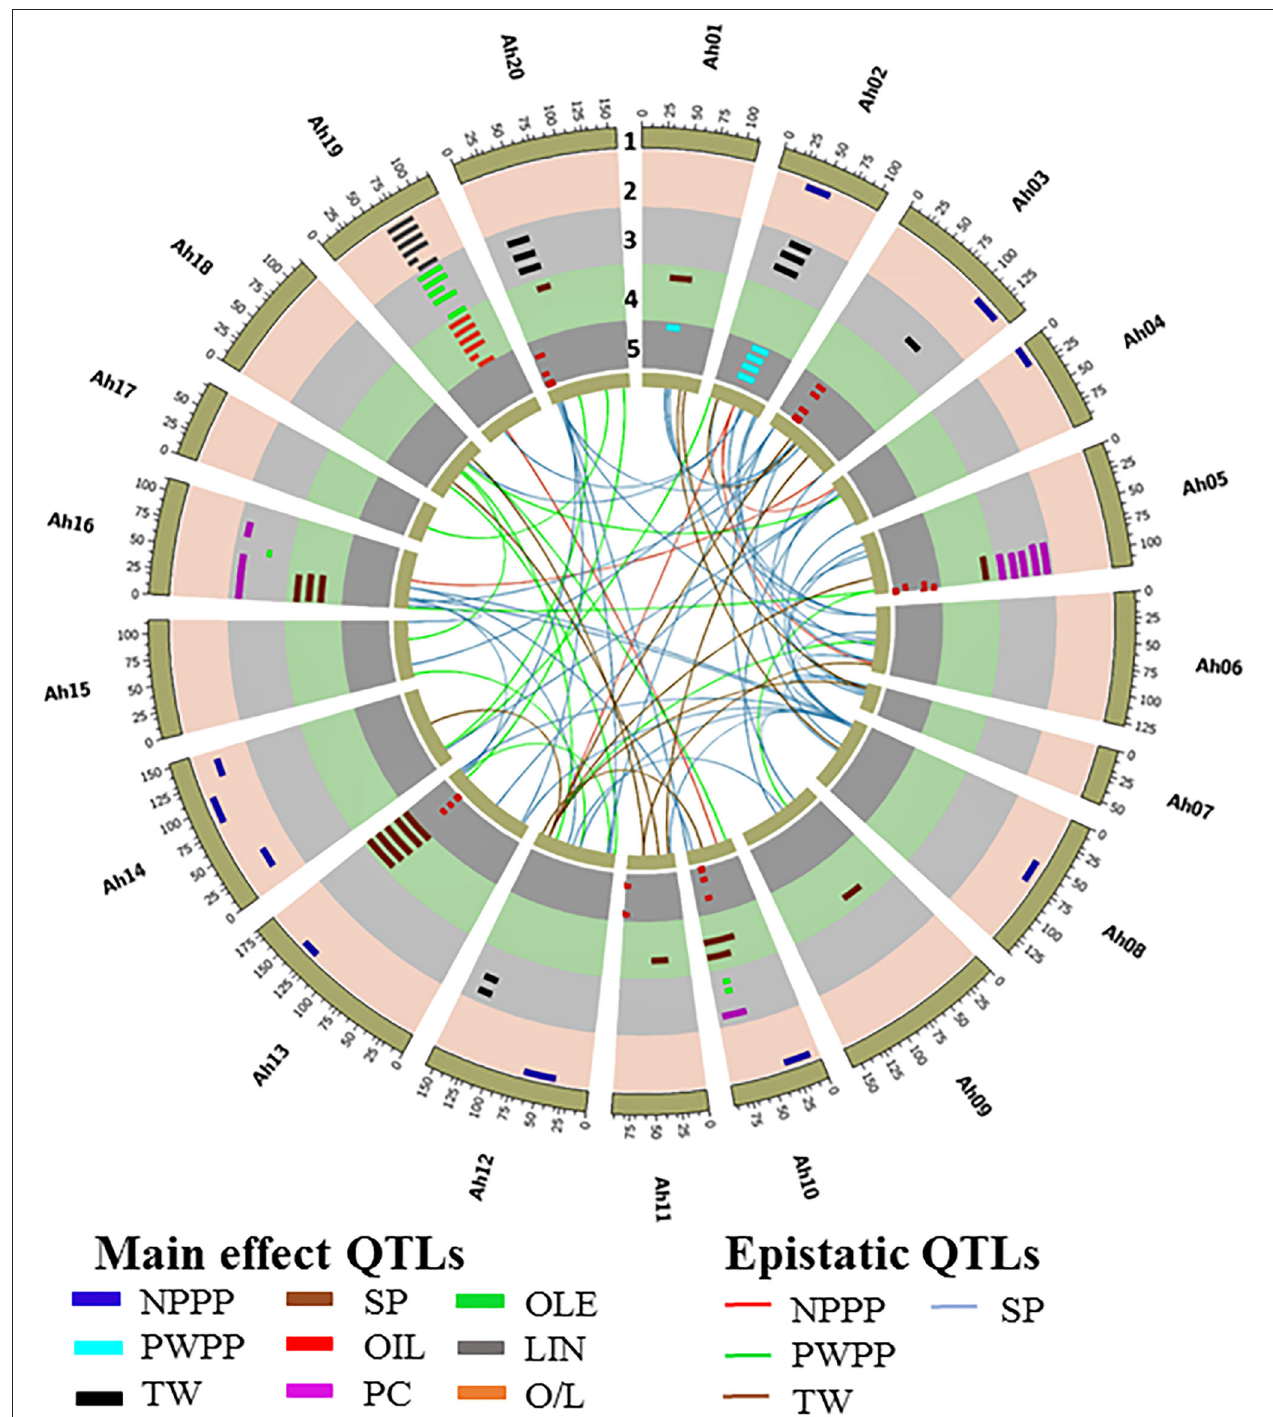
FIGURE 3 | Circos plot illustrating main effect and epistatic (QTL × QTL) QTLs identified for productivity and quality traits in ML population of TMV 2 and TMV 2-NLM of peanut. The tracks from outside to inside indicates (1) 20 chromosomes of tetraploid genome Arachis hypogaea, (2) main effect QTLs for number of pods per plant (NPPP) and linoleic acid (IAN) qNPPP–Ah02-1, qNPPP–Ah04-1, qNPPP–Ah08-1, qNPPP–Ah10-1, qNPPP–Ah12-1, qNPPP–Ah13-1, qNPPP–Ah14-1,qNPPP–Ah14-2, qNPPP–Ah14-3, qLIN–Ah19-1, qLIN–Ah19-2, qLIN–Ah19-3, qLIN–Ah19-4, qLIN–Ah19-5, qLIN–Ah19-6,